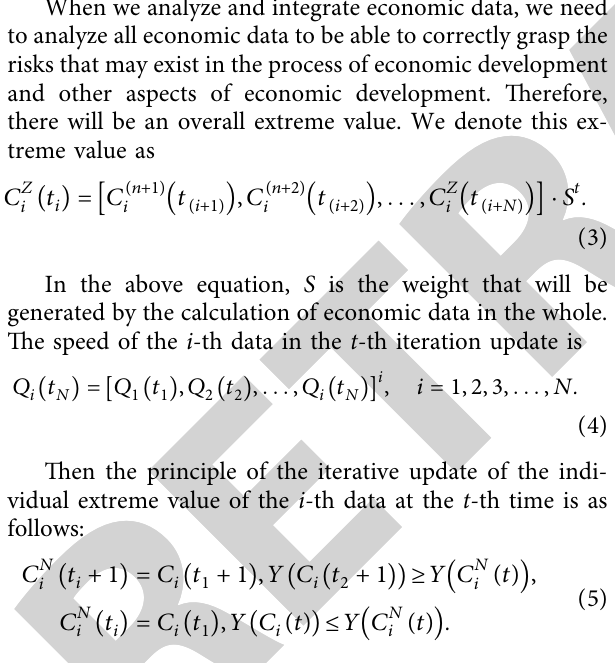
Figure 1: Application of artificial